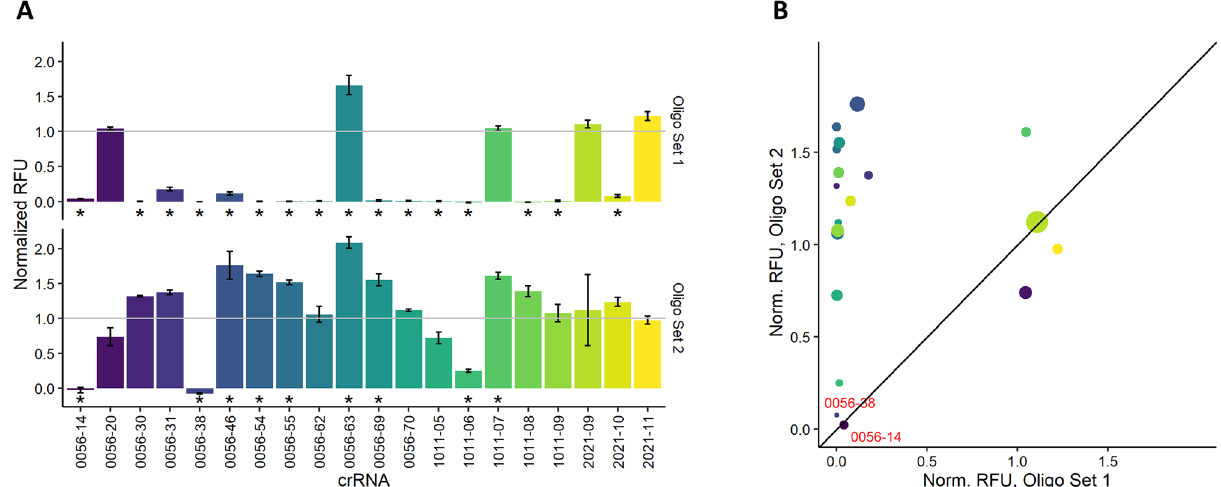
Figure 7. ( A ) Comparison of fluorescence sums normalized to internal control crRNA when crRNA are prepared from DNA oligos from different companies, where bars represent mean and error bars represent standard deviation (n = 3). ( B ) Comparison of normalized fluorescence sums via dot plot where red labels represent crRNAs with p -value < 0.05 as determined by analysis of variance and Tukey test against internal controls that remained poorly active despite DNA oligo